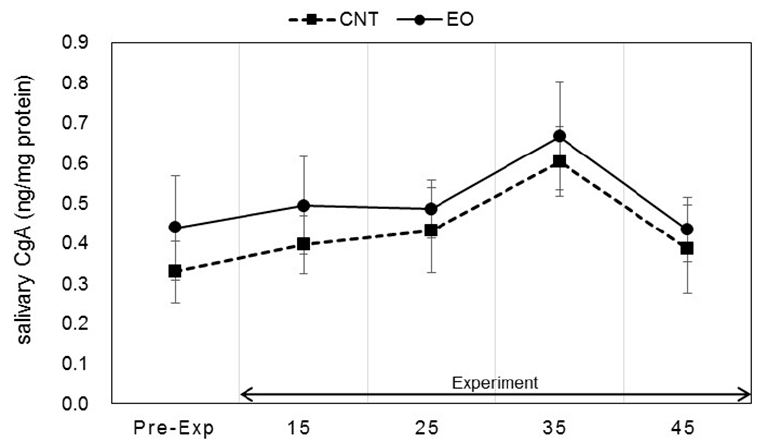
Figure 8. Variation of salivary CgA levels at pre- and during-experiment measurements. The plot in Figure 8 describes changes in the salivary CgA levels of participants in the control (square) and Japanese cedar wood essential oil (experimental; circle) conditions. CNT indicates the control condition, while EO indicates the experimental condition. Differences between conditions were not significant. Data are shown as mean ± SEM.